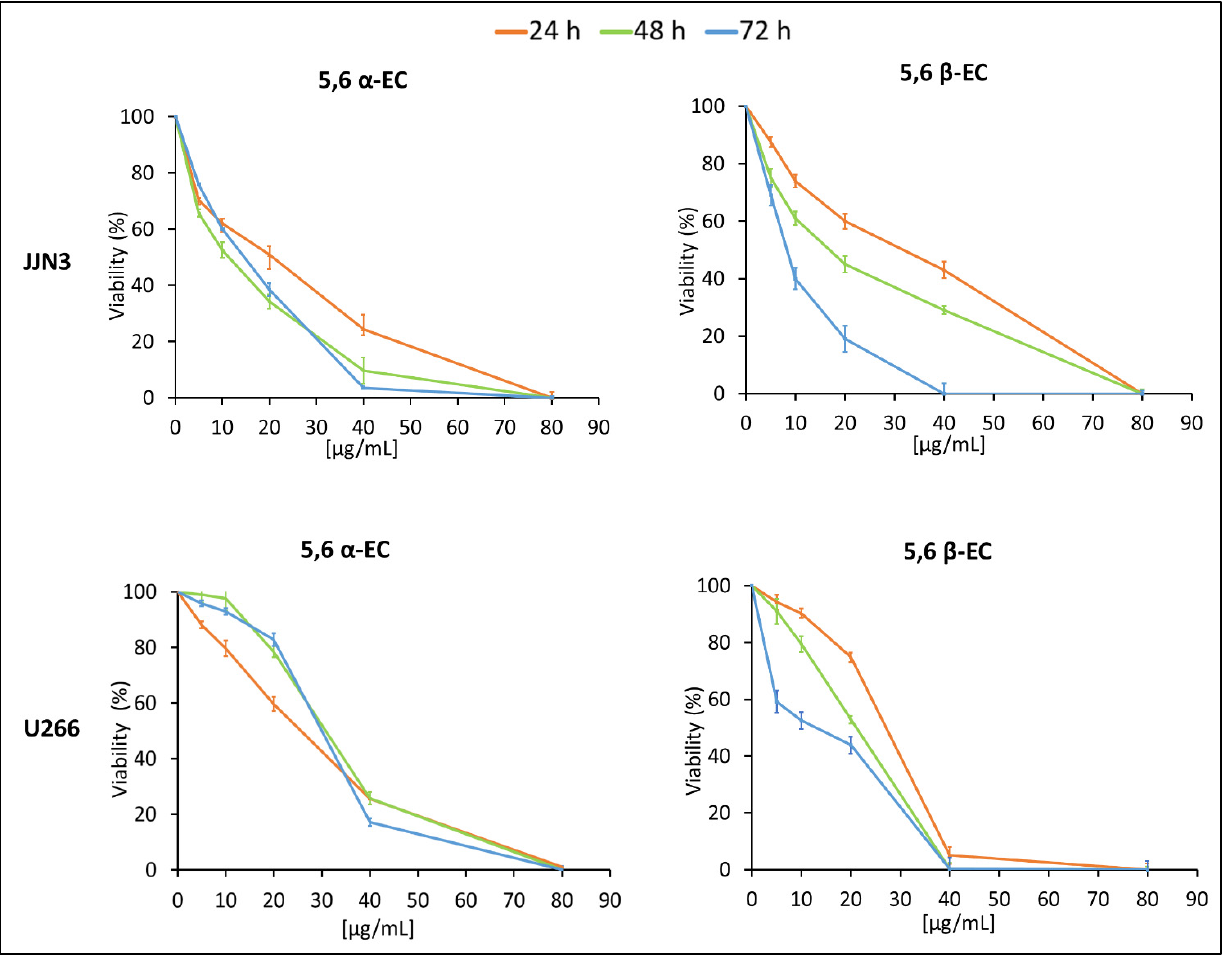
Figure 1. Evaluation of 5,6-ECs-induced cytotoxic effects on HMCLs. JJN3 and U266 cells were seeded in 96-well plates at the density of 2 × 10 5 cells/well for 24 h. Then, cells were cultured with 5-80 µg/mL 5,6 α -EC or 5,6 β -EC for 24-72 h and their viability assayed using a colorimetric MTT assay. Reported values are means ± SD from three independent experiments. No statistically significant difference between control (no treatment) and vehicle (EtOH-treatment) was